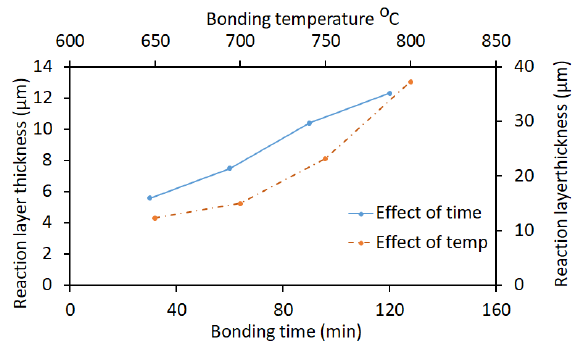
Figure 3. Relationship between the width of the reaction layer bonding time for Ti-6Al-4V and 316 stainless steel [59].